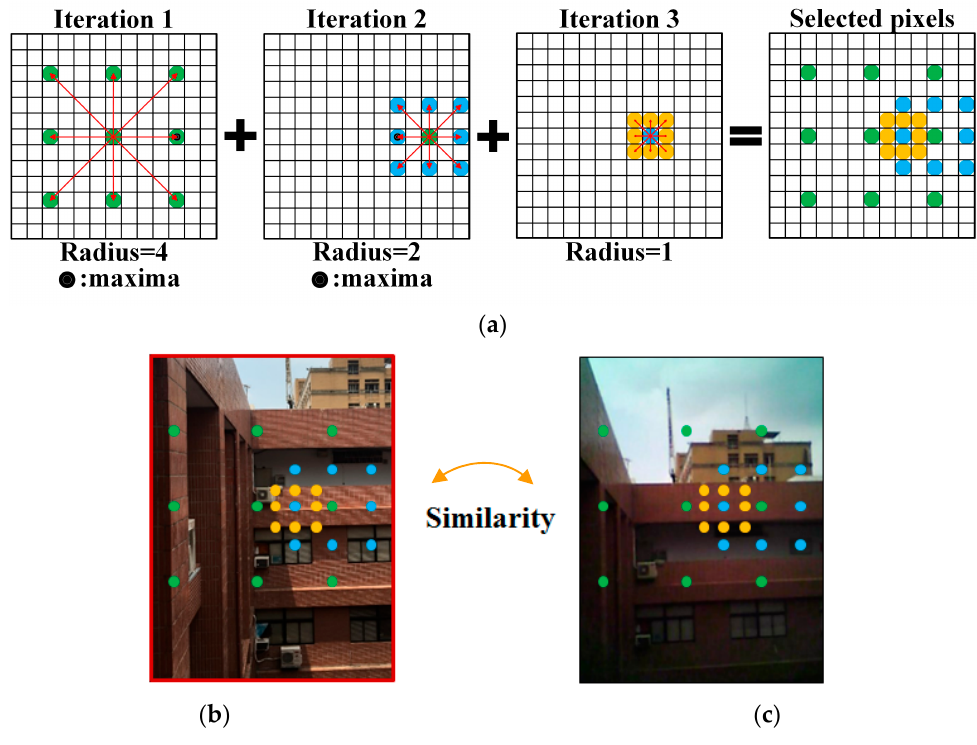
Figure 5. Illustration of TSS operation: ( a ) pixels selected to be examined in similarity; ( b ) selected pixels on template image; ( c ) selected pixels on registered image.